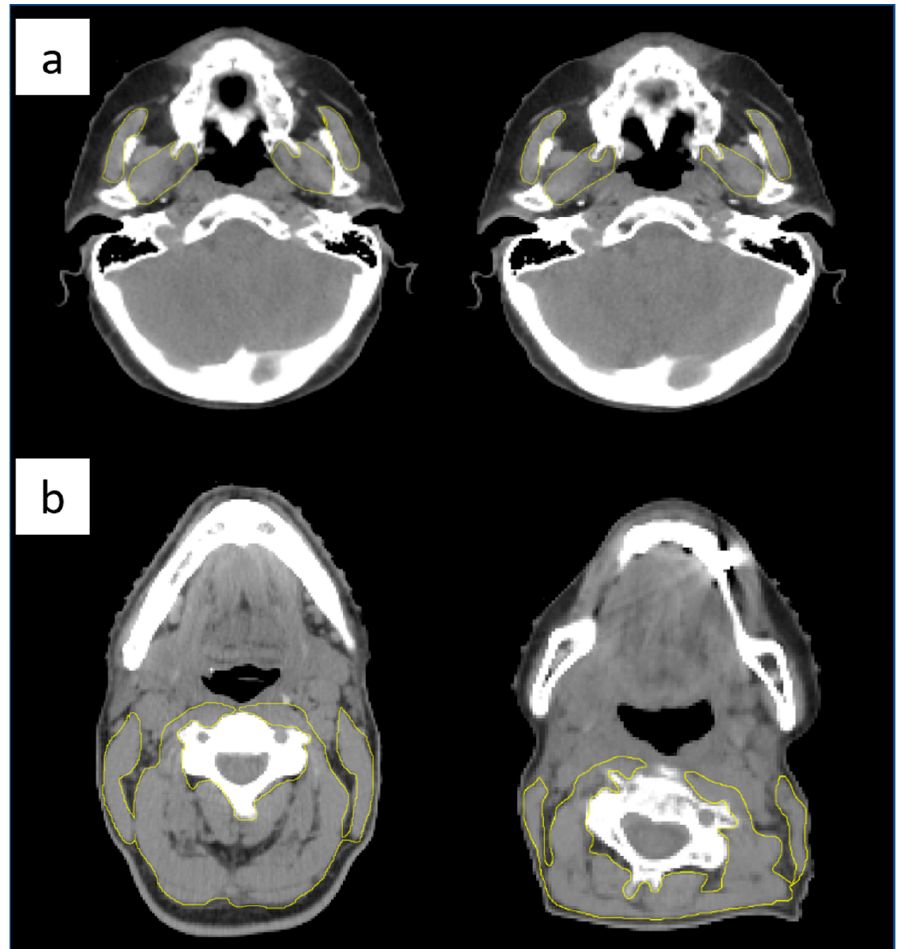
Figure 2. Axial CT-scan image delineation of the masticatory muscles ( a ) and paravertebral and sternocleidomastoid muscles at the level of the third cervical vertebra ( b ) in a non-sarcopenic patient ( left ) and in a sarcopenic patient ( right ).